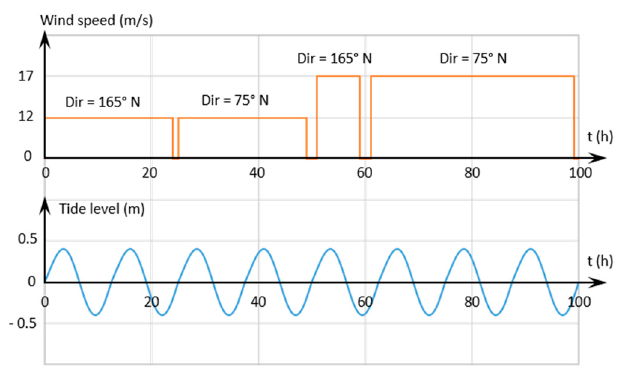
Figure 10. Sinusoidal tidal oscillation combined with the sequence of winds representative of an average year. average year.